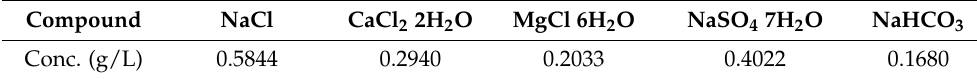
Table 1. Chemical composition of the electrolyte solution. Compound NaCl CaCl 2 2H 2